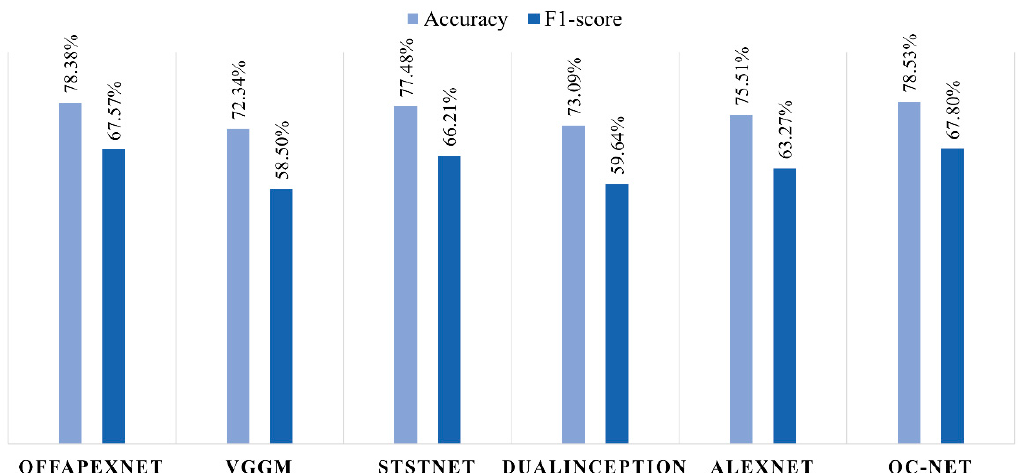
Figure 13. ME recognition performance of OC-Net and its benchmarked models.